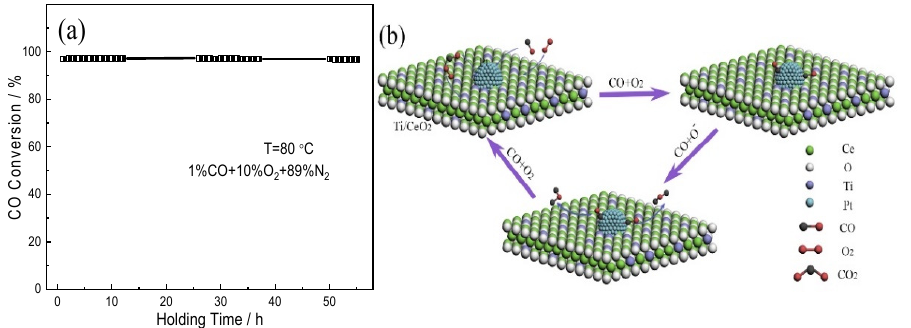
Figure 9. ( a ) The long-term stability of the (0.5TiO 2 − Pt)/CeO 2 catalyst; ( b ) a possible mechanism for reaction of CO on the (TiO 2 − Pt)/CeO 2 catalyst.